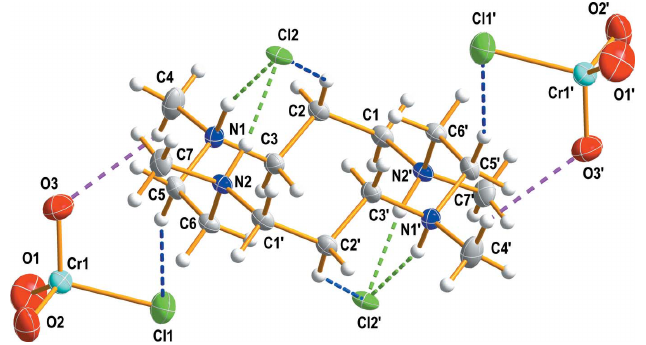
Figure 1 The structure of (I), drawn with displacement ellipsoids at the 50% probability level. Dashed lines represent hydrogen bonding interactions and primed atoms are related by the symmetry operation ( (cid:2) x + 1, (cid:2) y + 1, (cid:2) z ).